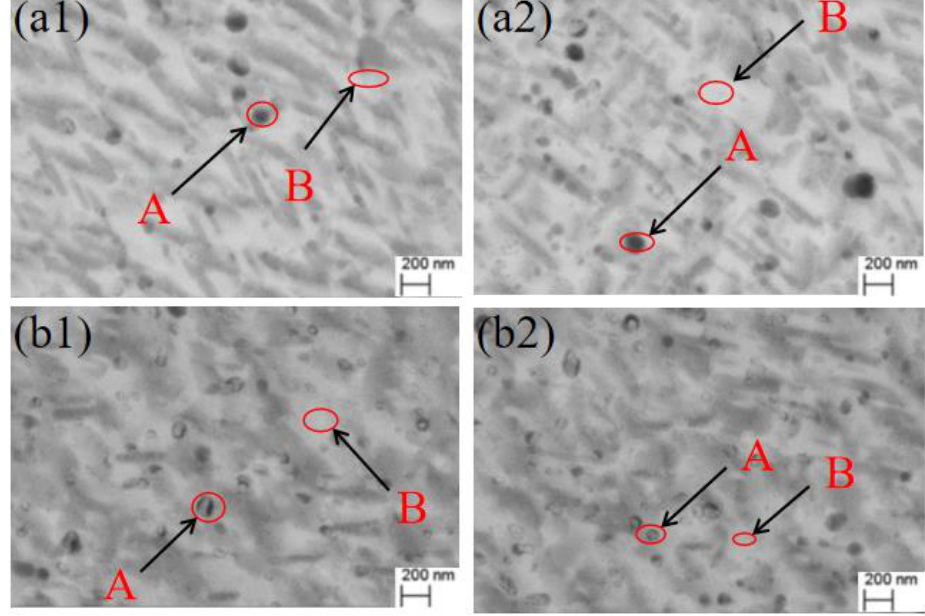
Figure 4. SEM microstructure of TNZ-xCu(T6); ( a1 ) TNZ-3Cu(T6-30m); ( a2 ) TNZ-3Cu (T6-2h); ( b1 ) TNZ-7Cu(T6-30m); ( b2 ) TNZ-7Cu (T6-2h). The morphology and microstructure of TNZ-3Cu(T4), TNZ-3Cu(T6-30m) and TNZ- 3Cu(T6-2h) samples were observed by TEM, as shown in Figure 5. From the diffraction